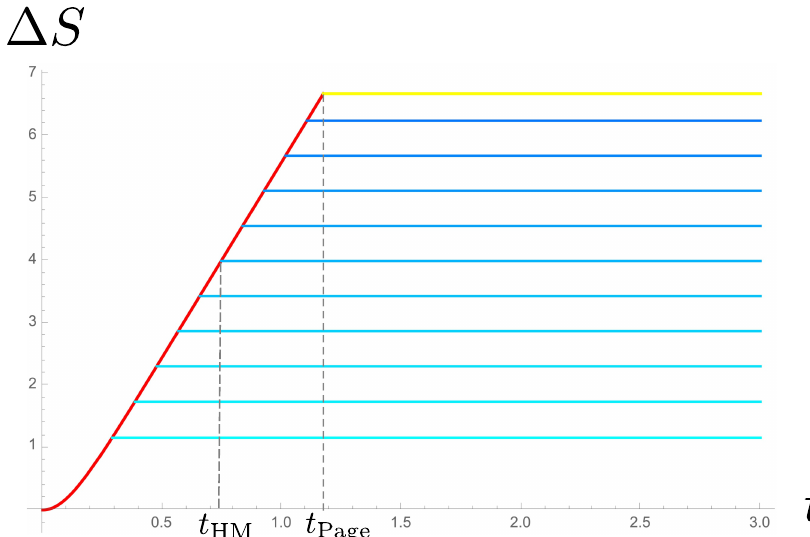
Figure 4 . Plot of ∆ S versus time for various bath sizes R , with fixed temperature T (and choosing the opening angle ∆ φ = 2 φ = π/ 10 and k = 1000 ). For the parameters chosen, the curves range Σ R = 0 . 1 /T at the bottom to R = R crit ≈ 0 . 39 /T at the top. As R increases, the value at which ∆ S saturates increases until it reaches the yellow curve at R = R . Beyond this size, the curves do crit not change.